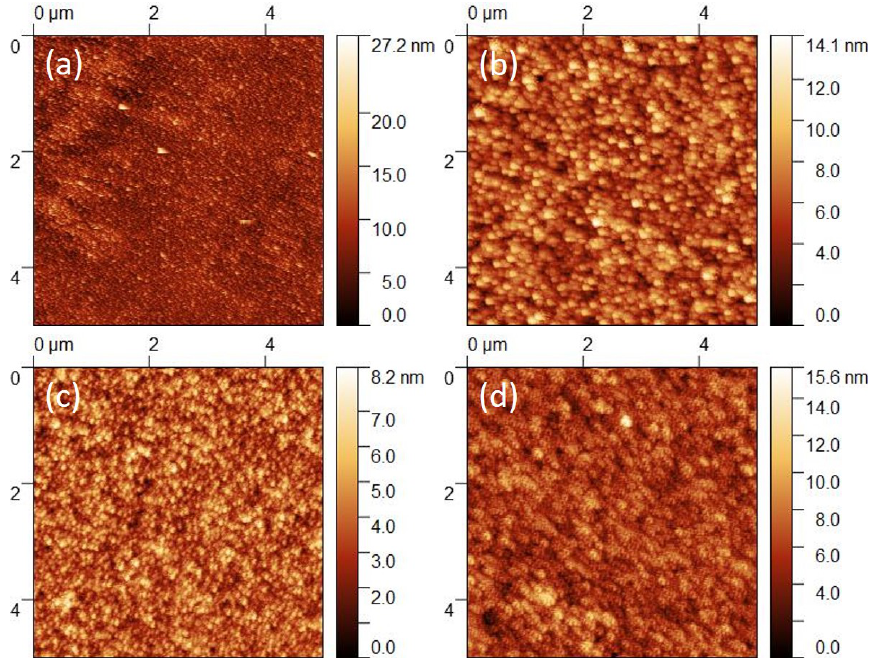
Figure 3. AFM 2D surface topography images of the RF-magnetron sputtered ZnSe thin films,